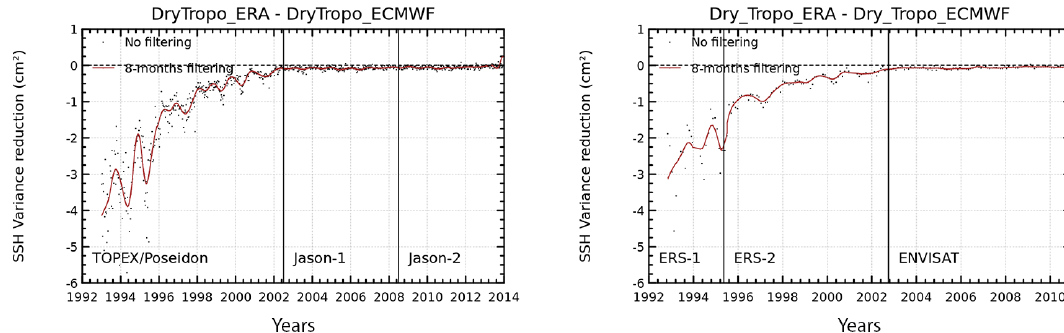
Figure 10. Temporal evolution of SSH variance differences at crossovers successively using the ERA-Interim and ECMWF operational DT corrections in the SSH calculation for TOPEX/Jason-1/Jason-2 series (on the left), and ERS-1/ERS-2/Envisat (on the right).